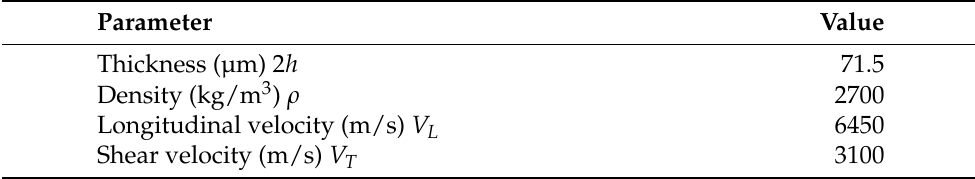
Figure 1. Dispersion curves of the S Lamb modes in a 71.5 µm thick aluminum plate: ( a ) dispersion curves in the real plane k r - f with a black arrow indicating the position of the S 1 S 2 -ZGV mode; ( b ) three-dimensional view ( k r , k i , f ) of the complex dispersion curves for the first symmetrical modes propagating in both directions with positive (solid lines) and negative (dashed lines) group velocity, with subscript “b” for backward mode: S 0 , S 2 , S 1 , and S 4 modes are plotted in solid lines and S − 0 , S − 2 , S − 1 , and S − 4 are plotted in dashed lines. The colors of S 0 / S − 0 , S 2 / S − 2 , S 1 / S − 1 , and S 4 / S − 4 modes are blue, green, red, and black, respectively. Two black solid circles show the position of the ZGV point as indicated by the black arrows labeled “ZGV”. Table 1. Elastic properties for aluminum